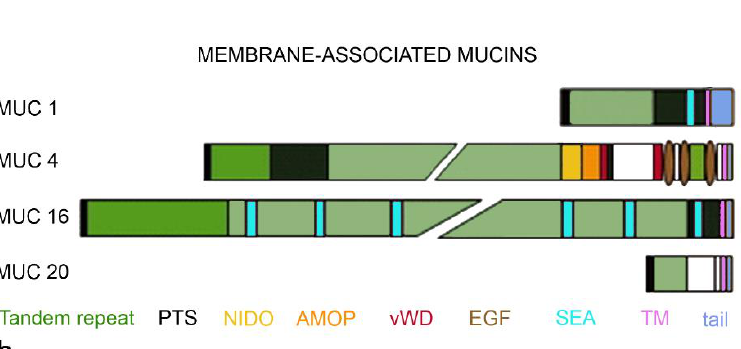
Figure 3. Mucin mesh ( a ) and structure of secreted and membrane-associated mucins ( b ). C- (yellow dots) and N-termini (blue dots) of the mucin monomers are sites of intermolecular disulfide bonds ( a ). Electrostatic interactions occur through carboxylic groups of sialic acid, hydrogen bonding through functional groups of the oligosaccharides and hydrophobic interactions via cysteine-rich domains. Secreted MUC5B and MUC5AC have D-domain at the C-terminus, and B-, C-domain and Cys knot are the von Willebrand factor-like domains important for polymerization ( b ). Domains of the membrane-associated MUC1, MUC4, MUC16 and MUC20 regulate cellular processes (growth, motility, differentiation). Abbreviations: AMOP, adhesion-associated domain in MUC4 and other proteins; EGF, epidermal growth factor; MUC11p, MUC11p15-type domain; NIDO, nidogen-like domain; PTS, proline, threonine, serine rich; SEA, sea urchin sperm protein; tail, cytoplasmic tail; TM transmembrane domain; vWD, von Willebrand factor D. MUC4 and MUC20 contain unique domains, which are shown in